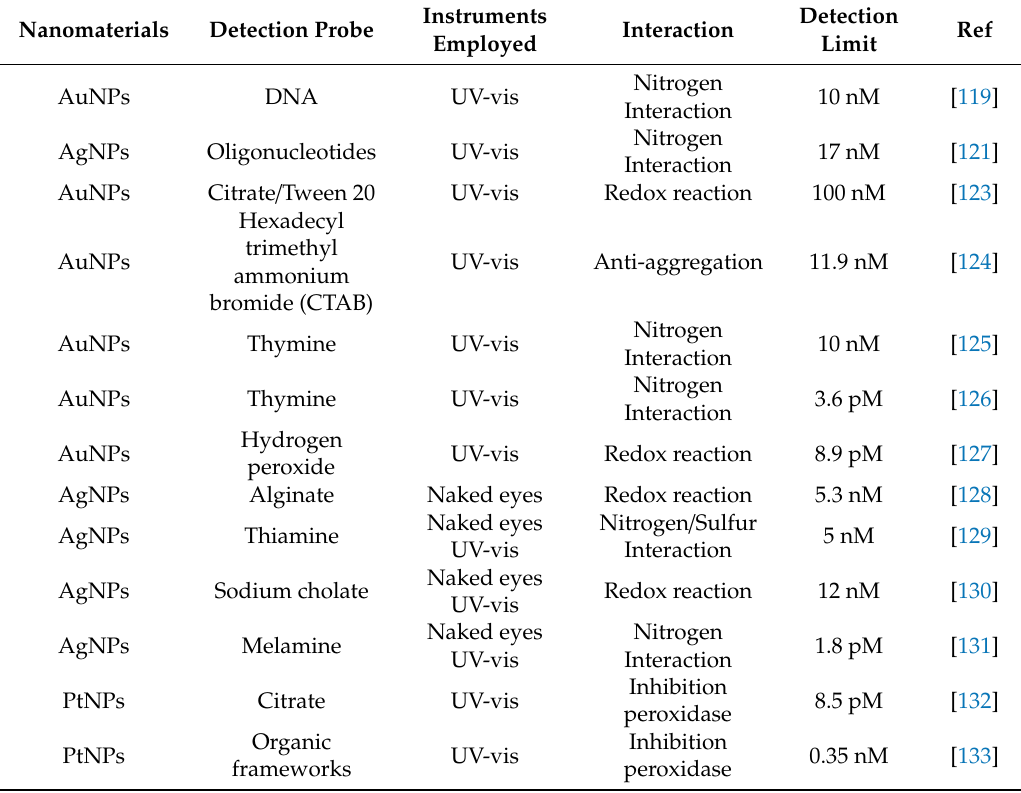
Table 3. Recent reported AuNPs / AgNPs / PtNPs-based colorimetric biosensors for Hg 2 + detection.